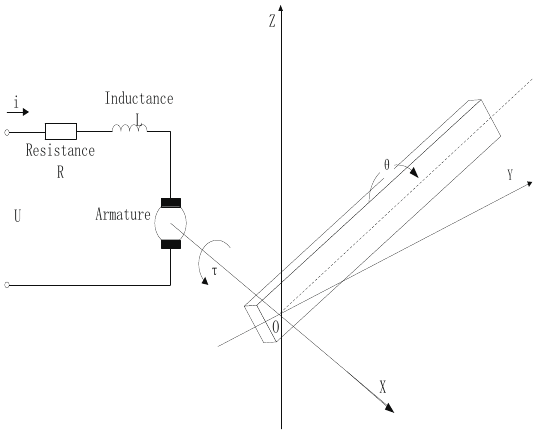
Figure 1. Configuration of one-link manipulator with the inclusion of motor